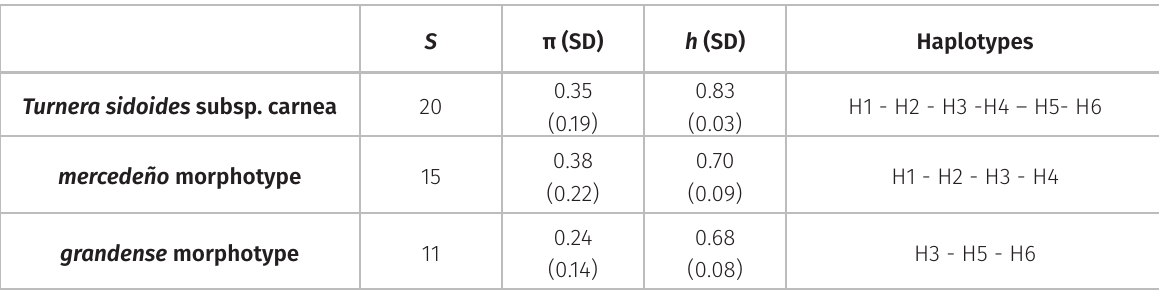
Table V. Summary statistics and haplotypes obtained from intergenic cpDNA sequences analyzed in morphotypes of Turnera sidoides subsp. carnea . S= polymorphic< sites, π= nucleotide diversity, h = haplotype diversity, SD= standard